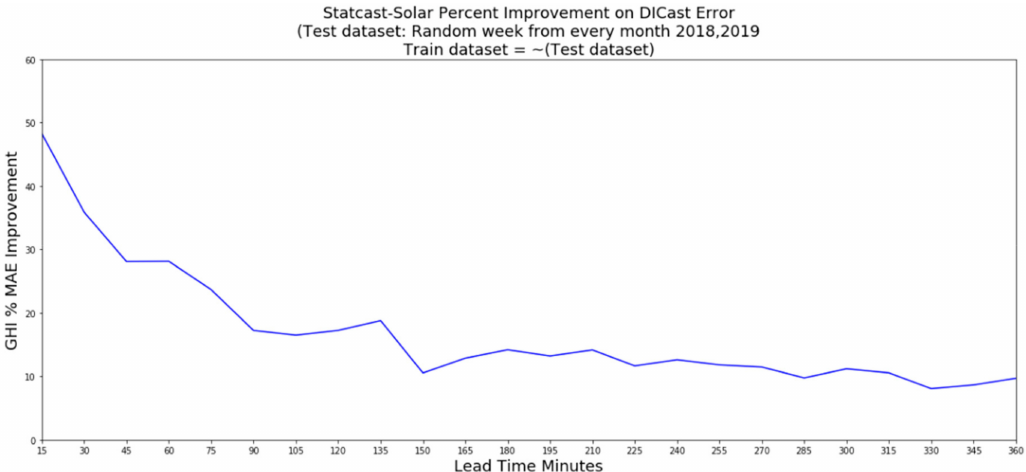
Figure 12. Percentage improvement of StatCast-Solar over DICast for all lead times from 15 min to 360